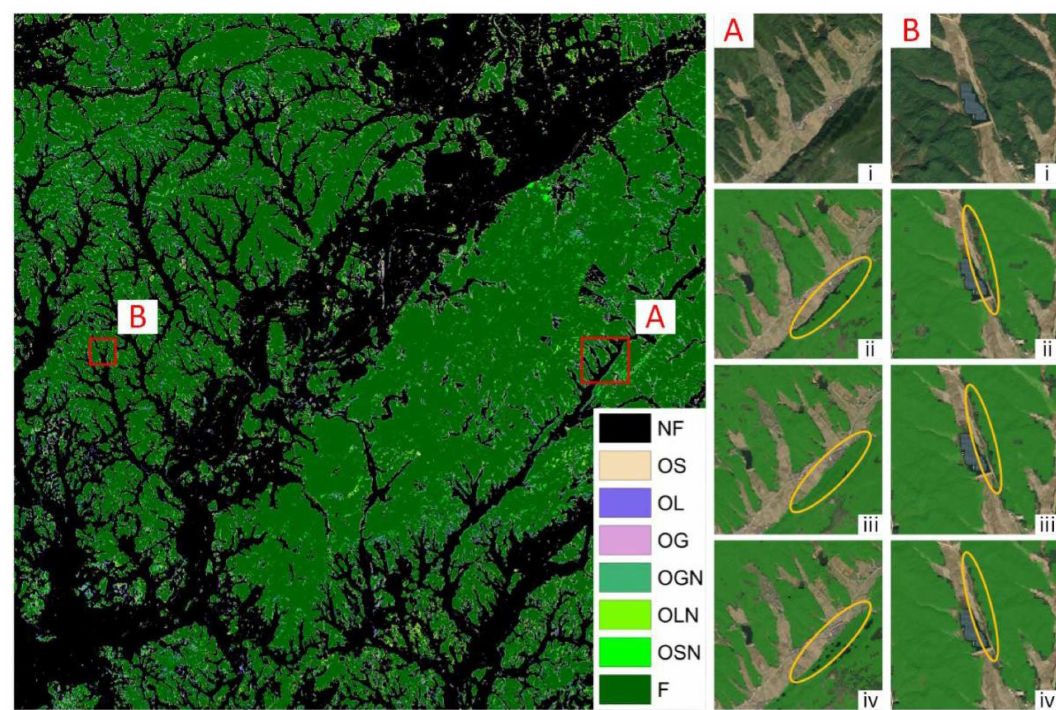
Figure 9. Classification results of images from different sensors in area 9.